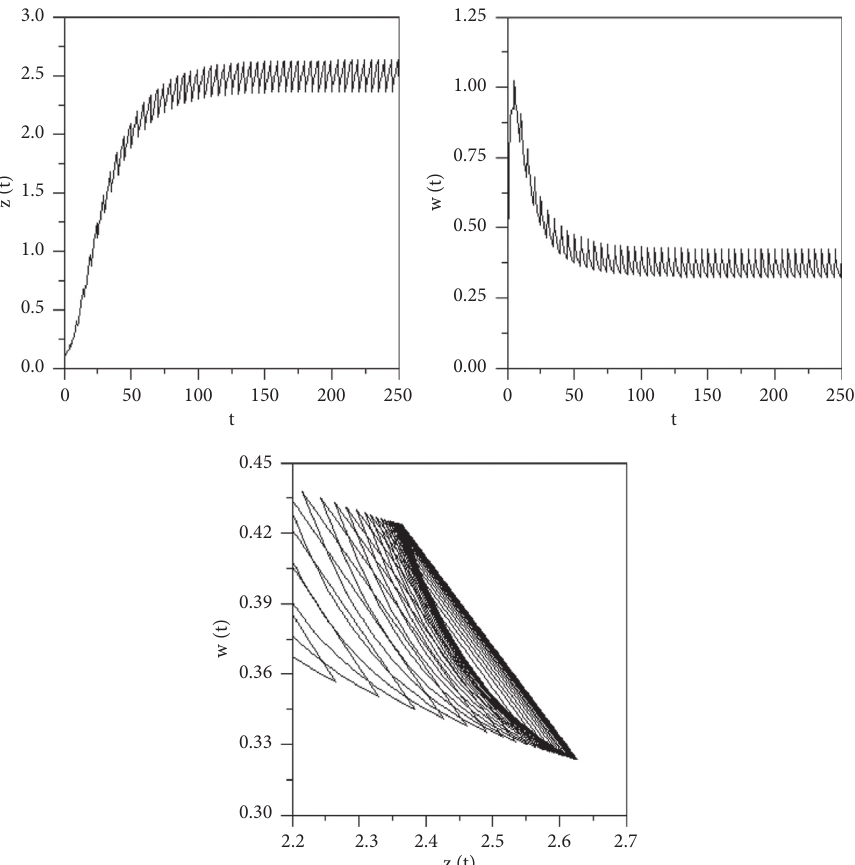
Figure 2: A computer simulation of systems (5) and (6) showing the permanence of the system. Here, a � 0 . 58 , a � 0 . 19 , a � 0 . 39 ,a � 0 . 1 ,a � 0 . 34, a 3 4 5 6 � 0 . 96 ,k � 0 . 99, k � 0 . 84 ,k � 0 . 65 , μ � 0 . 1 , ρ � 0 . 1 ,T � 5 ,z ( 0 ) � 0 . 1, and w ( 0 ) � 0 . 1 in which all conditions in Theorem 2 are k 3 4 5 6